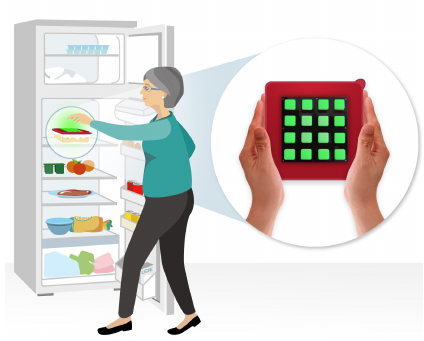
Figure 7. A prototype of an augmented Tupperware TM with the 4 × 4 button-RGB LED matrix integrated in its